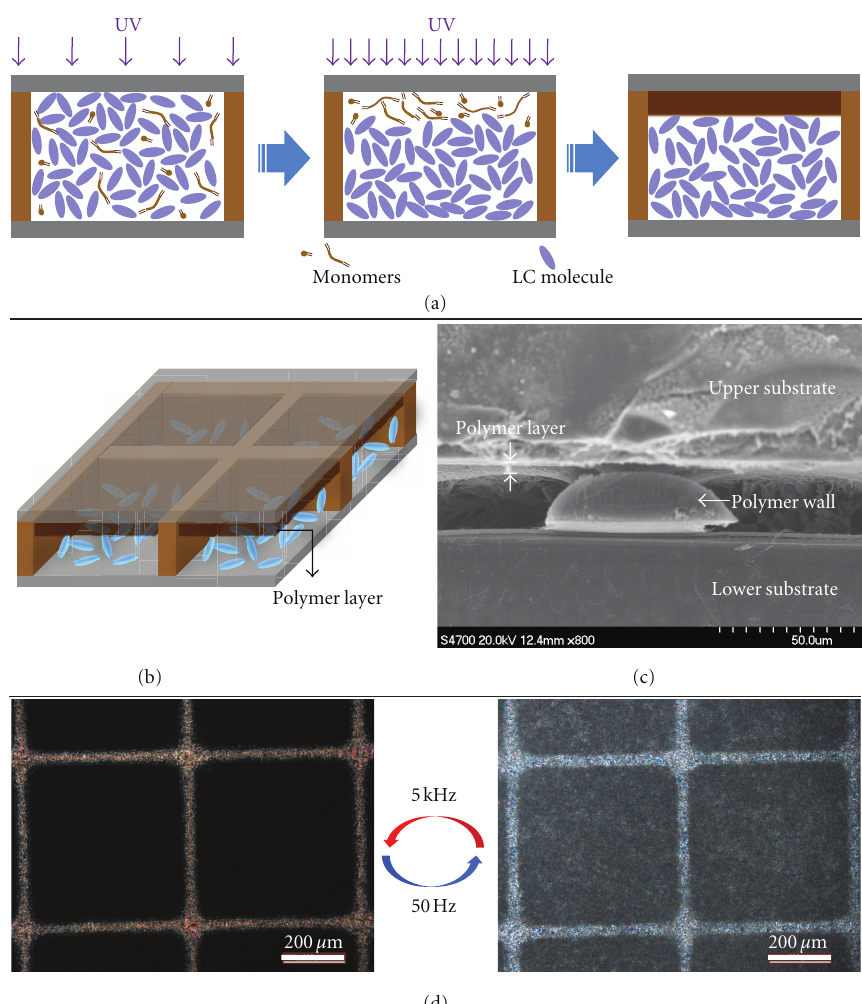
Figure 4: (a) The process of LC/monomer encapsulation; (b) polymer layer in space configuration; (c) SEM image of encapsulated cell by polymer layer; (d) the transparent and opaque states images observed by